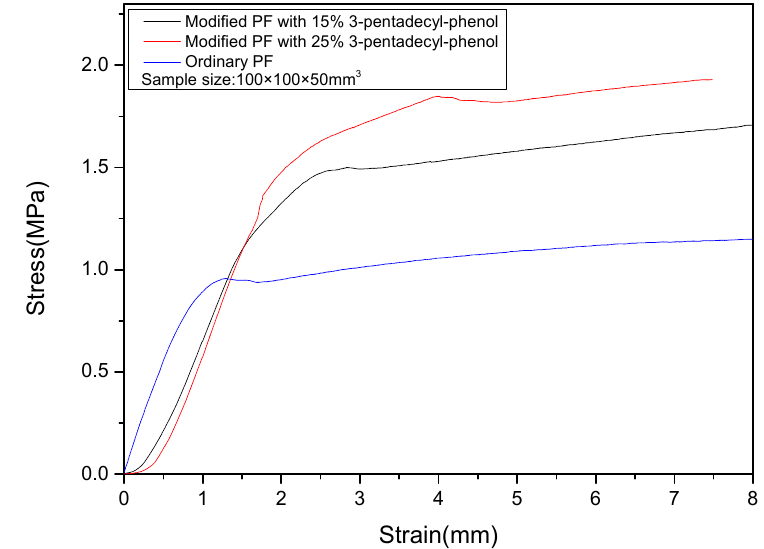
Figure 7. The compressive characteristics of phenolic foam: stress-strain curves.